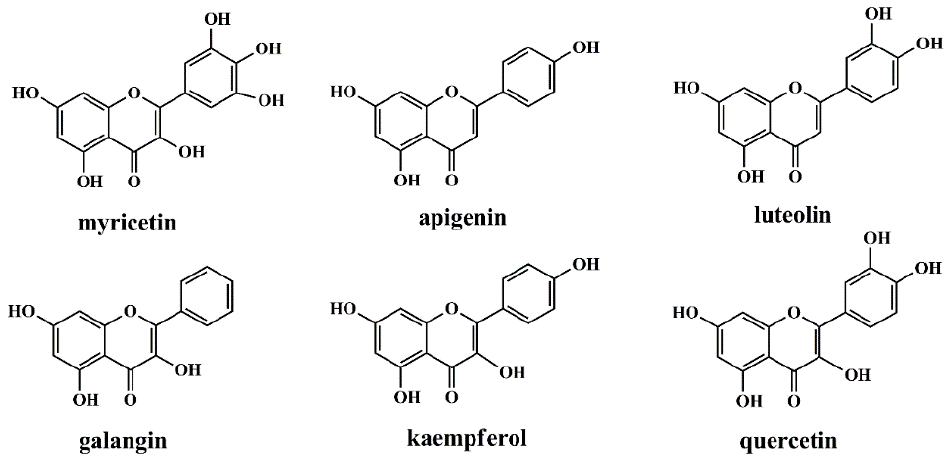
Figure 1: The studied chemical structures of dietary